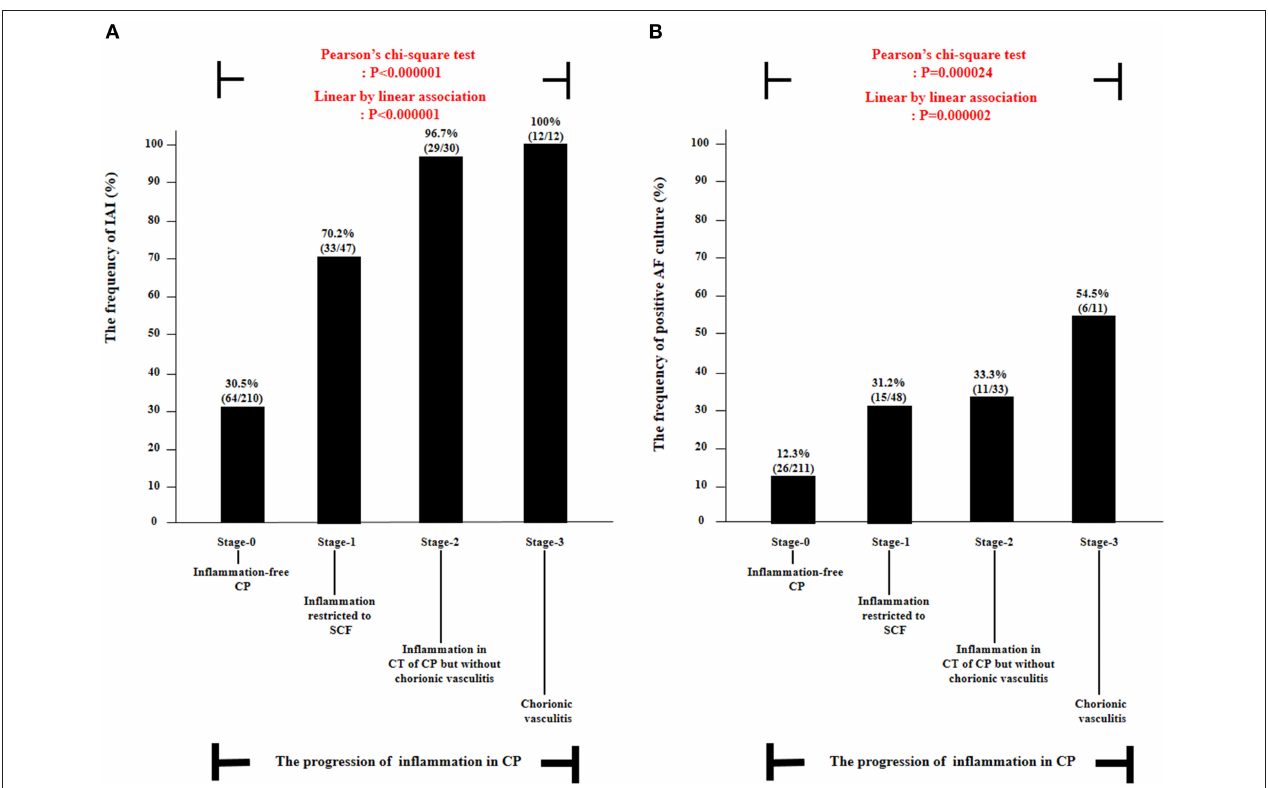
FIGURE 2 | The frequency of intra-amniotic inflammation (IAI) (A) and positive amniotic fluid (AF) culture (B) according to the progression of inflammation within chorionic plate (CP) [i.e., stage-0, inflammation-free CP vs. stage-1, inflammation restricted to subchorionic fibrin (SCF) vs. stage-2, inflammation in the connective tissue (CT) of CP without chorionic vasculitis vs. stage-3, chorionic vasculitis] among preterm gestations. Each P -value is shown in the graph. AF culture results were available in 303 patients. IAI results were available in 299 patients, and those were not examined in 10 patients due to the limited amount of AF remaining.